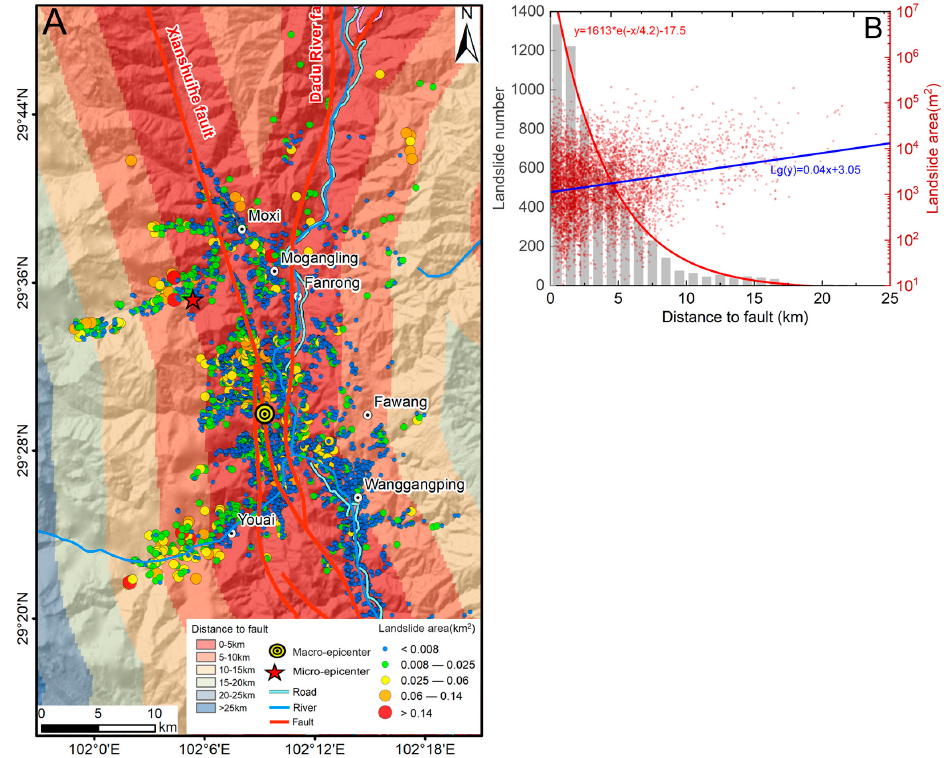
Figure 14. ( A ) coseismic landslide distribution with distance to fault; ( B ) correlations between landslide distribution and distance to fault.